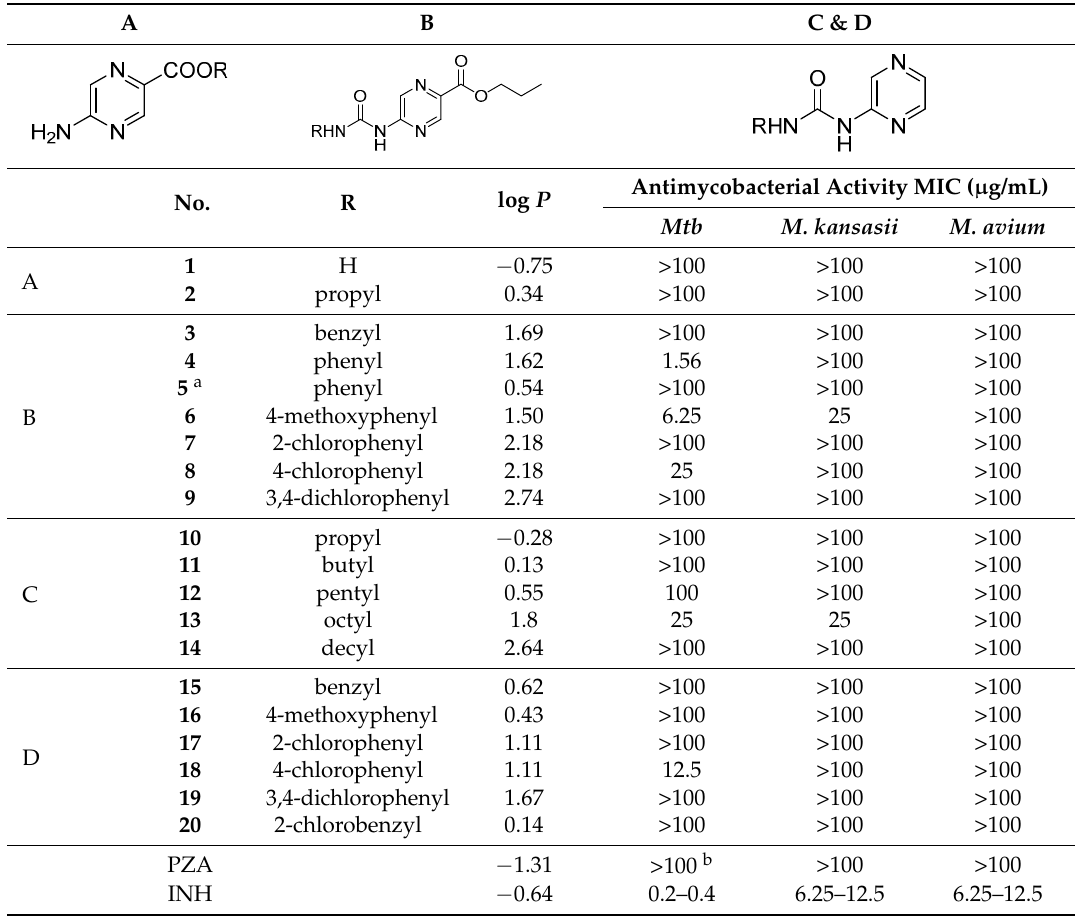
Table 1. Structure of prepared compounds, antimycobacterial activity expressed by minimum inhibitory concentrations (MIC), and cytotoxicity expressed by IC 50 values.